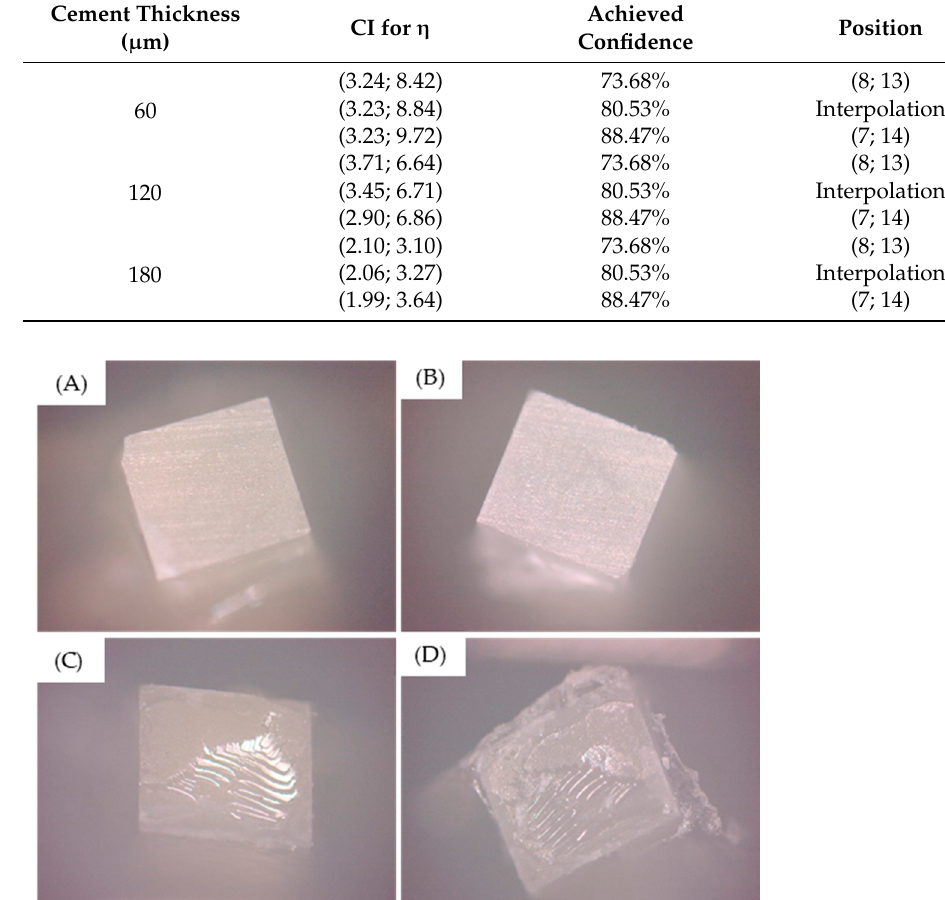
Table 6. Stress peaks (in MPa) calculated * for each adhesive interface component.